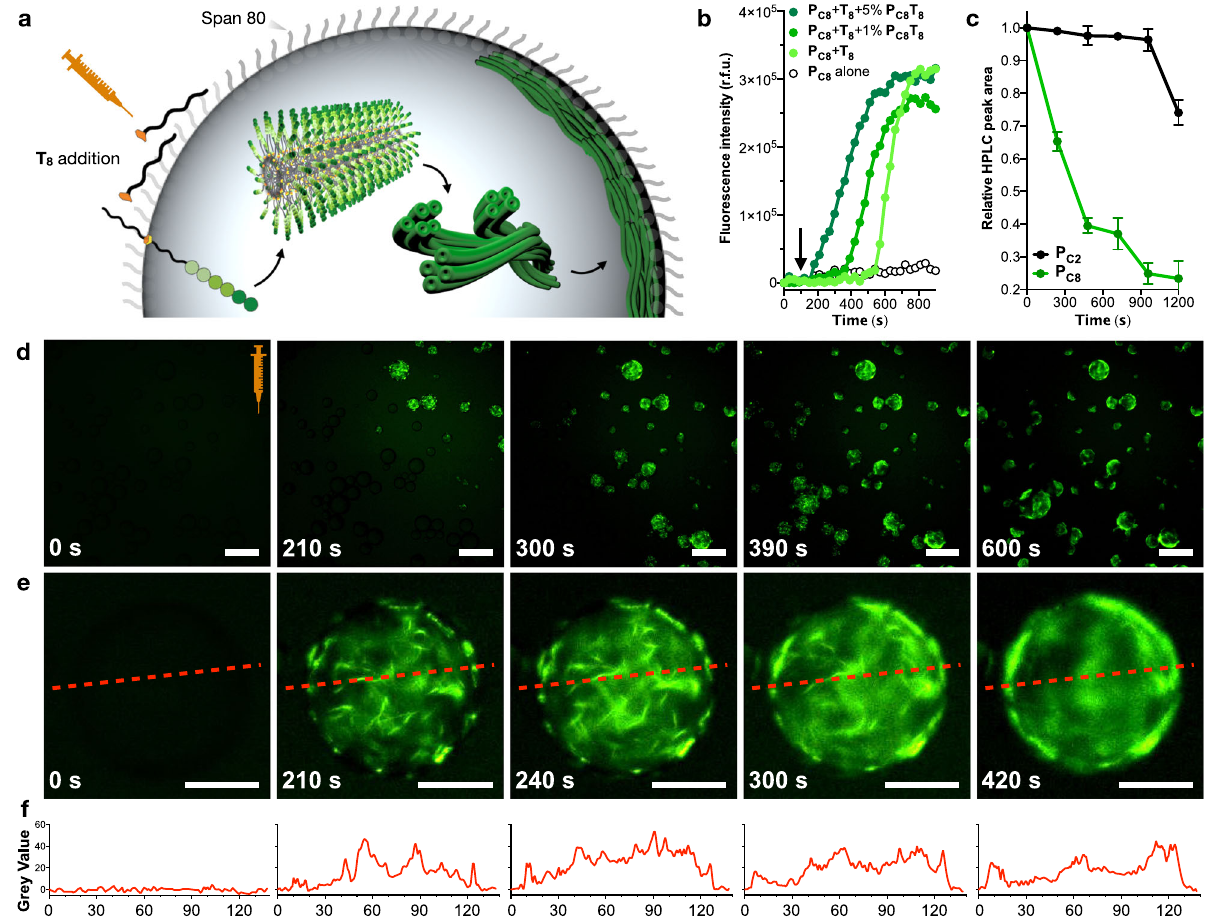
Fig. 2 Physical autocatalysis in water-in-oil emulsion. a Schematic showing the autocatalytic fi bre-forming reaction in aqueous droplets. Dormant P C8 precursor loaded into the microdroplets reacts with T 8 added to the external oil phase, thus triggering P C8 T 8 production and fi brillation, ultimately generating cortical micro fi brillar bundles at droplet interfaces. Note all droplets in this manuscript contain the surfactant Span 80. b Time-dependent ThT emission in the presence of the con fi ned reaction between P C8 and T 8 doped with their product P C8 T 8 (1 – 5% mol, dark greens), no doping (light green) and negative reaction control without T 8 (white). Octanal ( T 8 ) is added to the samples after 100 s (arrow). c Plots showing the competition between P C8 (green) and P C2 (black) in droplets; data collected by HPLC (222 nm); n = 3 (mean ±SD). d , e Fluorescence micrographs showing diffusion-dependent reaction after addition of T 8 . The syringe indicates the point of addition of T 8 . Scale bars = 200 µ m ( d ) and 50 µ m ( e ). f Intensity pro fi les of droplets shown in e